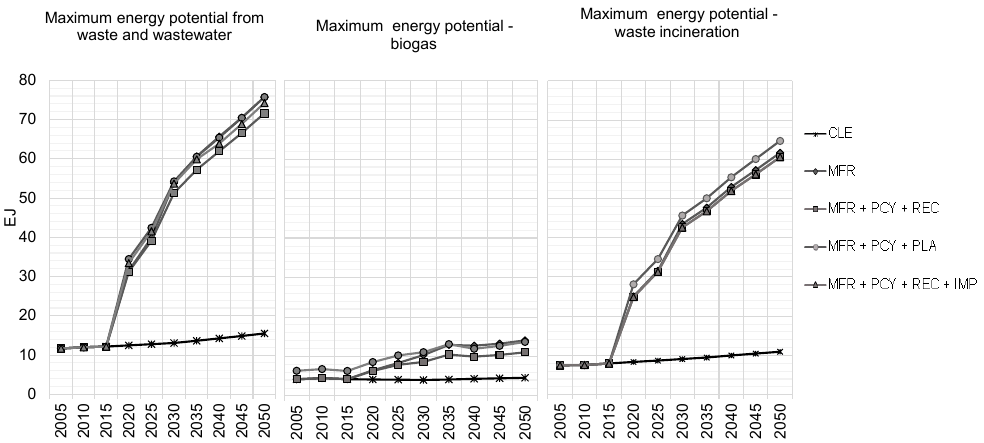
Figure 5. Maximum global energy recovery potential from waste and wastewater treatment by scenario.